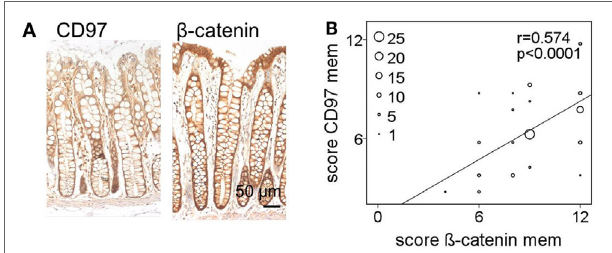
FigUre 3 | In normal colon membranous CD97 and β -catenin correlate strongly. (a) CD97 but not β -catenin showed an expression gradient along the crypt axis in normal colon. (B) Correlation of staining scores for membranous (mem) CD97 and β -catenin in normal colon. The circle size represents the number of patients (1: 1–4, 5: 5–9, 10: 10–14, 15: 15–19, 20: 20–24; 25: > 25